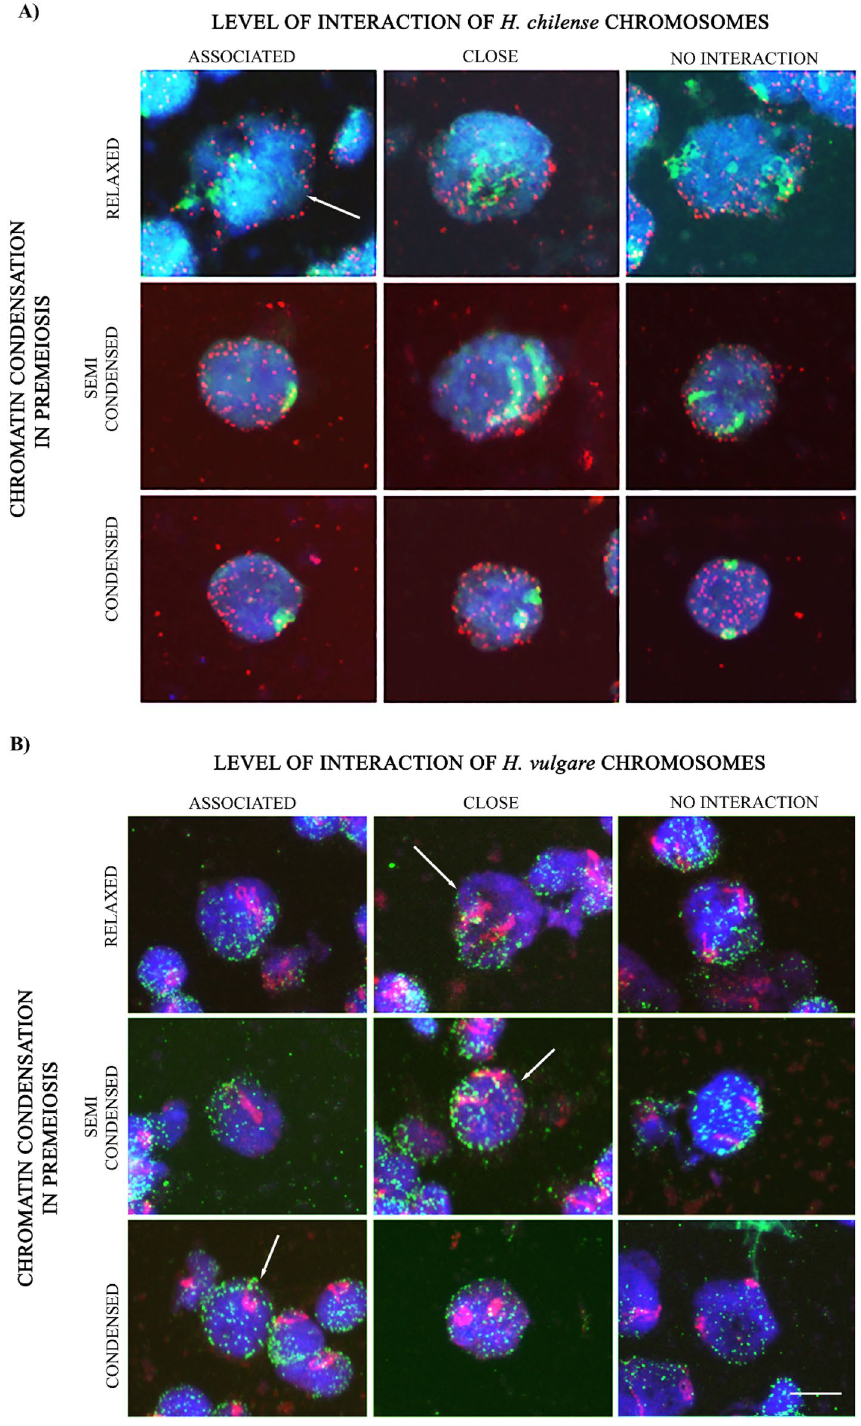
Figure 2. Genomic in situ hybridization to premeiotic chromosome spreads in wheat lines carrying 7 H ch H. chilense and 7 H v H. vulgare additions, respectively. Simultaneous visualization of ( A ) H. chilense chromosomes (green) and telomeres (red) and ( B ) H. vulgare homologous chromosomes (red) and telomeres (green). Columns show the spatial disposition of homologous chromosomes within the nucleus having no apparent interaction, being in proximity or associated. Rows show three different stages of chromatin condensation in somatic cells: relaxed, semi-condensed and condensed. Scale bar represents 10 μm for all